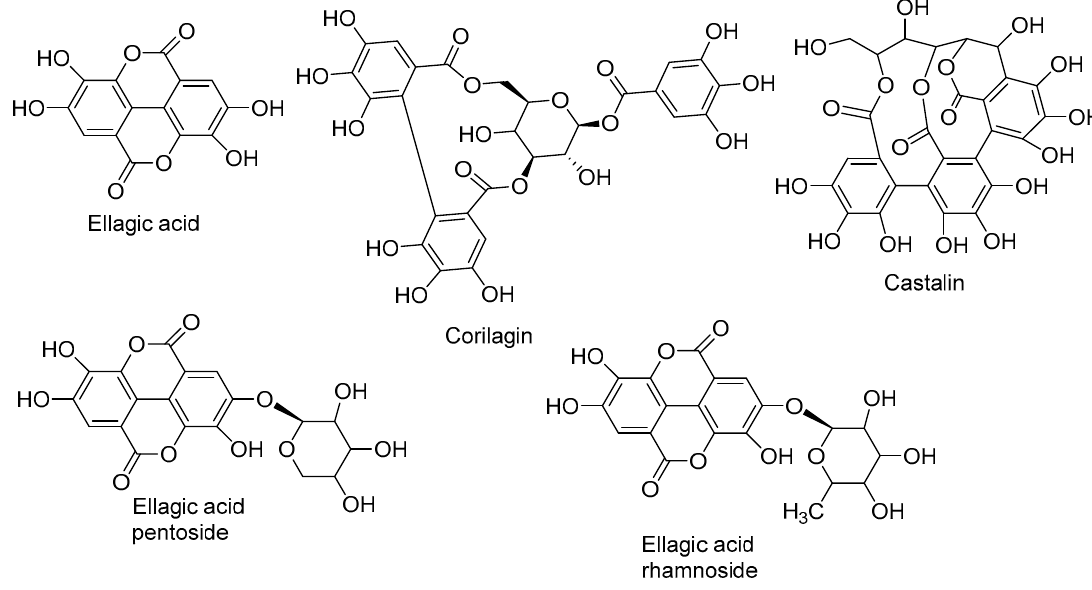
Figure 7. Structure of the main ellagic derivatives identified in N. alba extracts.